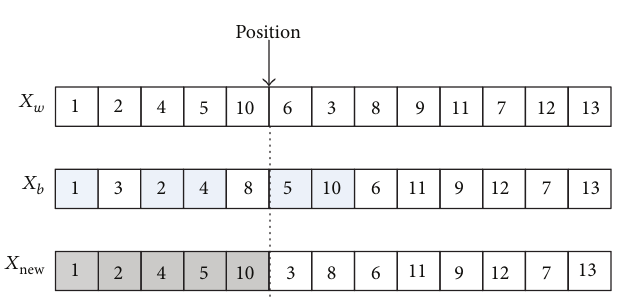
Algorithm 2: Feasible schedule generation procedure.